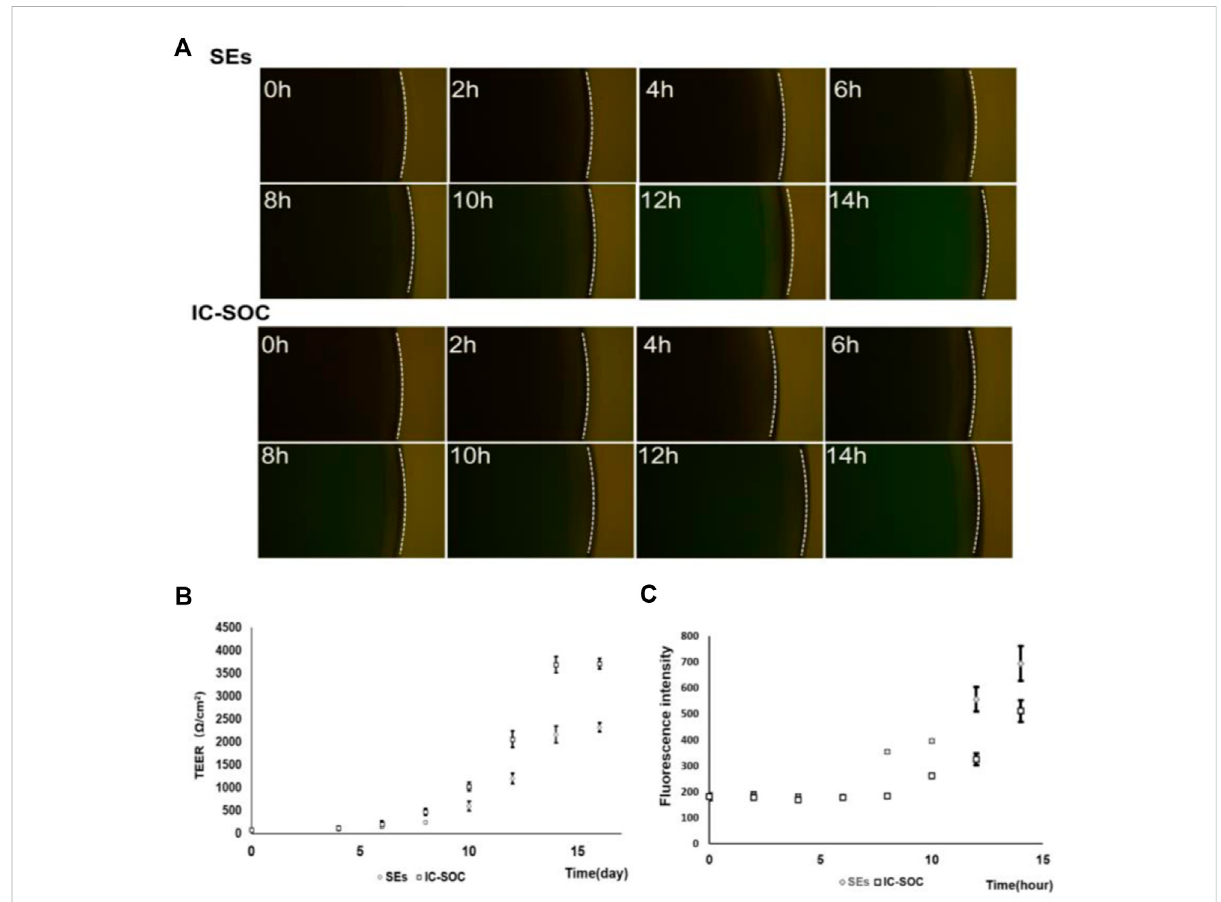
FIGURE 3 Barrier function analysis of the IC-SoC. (A) Fluorescent molecule permeability of the SEs and the IC-SoC. (B) TEER values of the IC-SoC within 14 days of air – liquid culture. (C) Values of cascade green as the SEs and the IC-SoC (A) , which showed the fl uorescence intensity of molecules penetrated after different hours ( n = 5 per